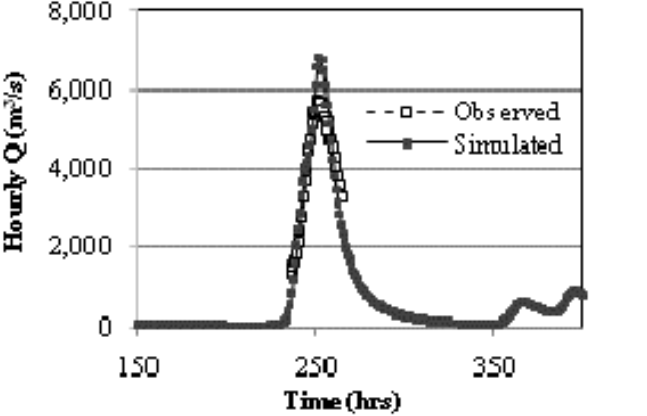
Fig. 9. Hourly water discharge at Tateyama station (11 July 2002).